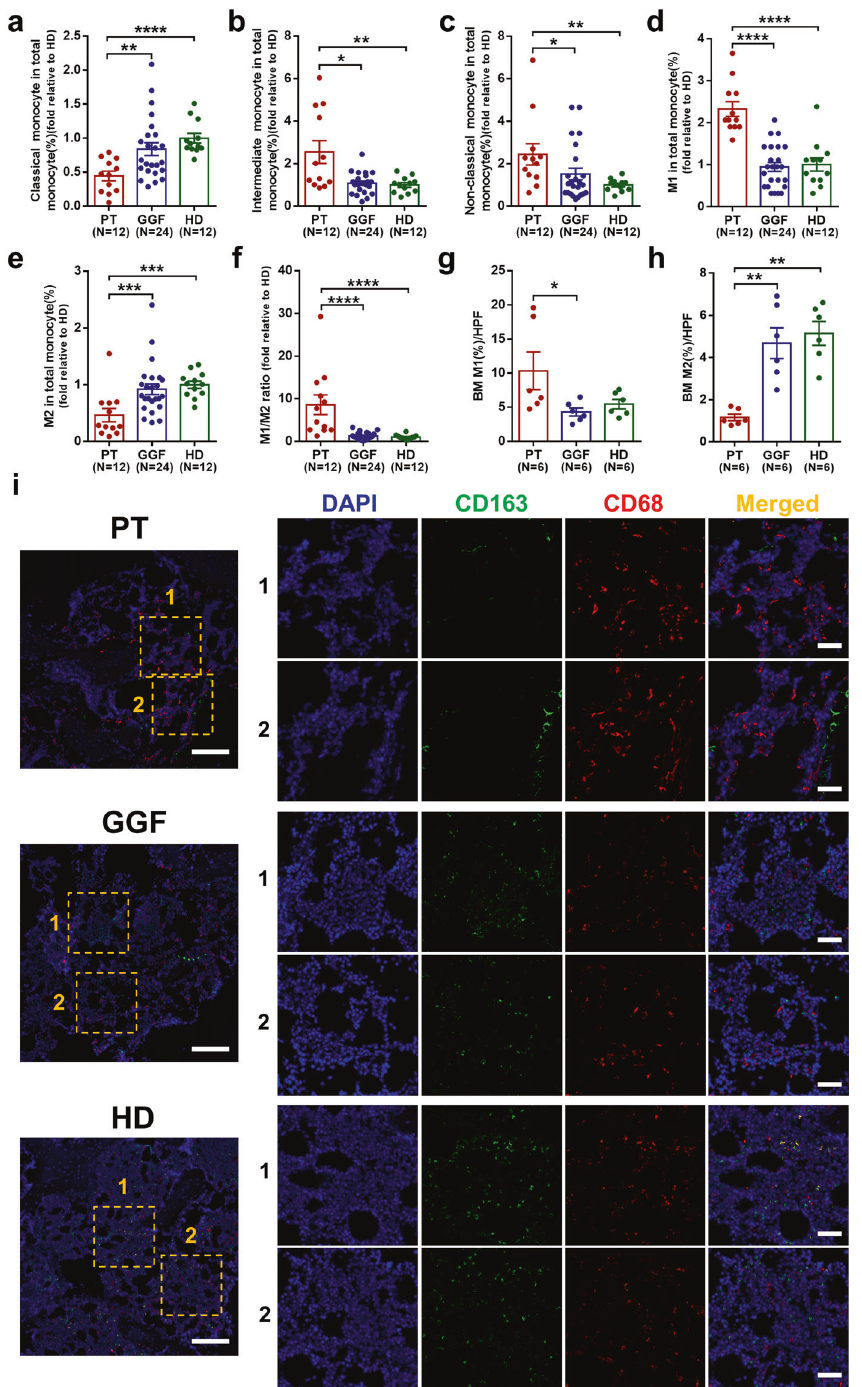
Fig. 1 Altered distribution of monocyte – macrophage subsets in the bone marrow of PT patients. Percentage of a classical monocytes, b intermediate monocytes, c non-classical monocytes, d M1 M Ф s, and e M2 M Ф s in the BM of PT patients, GGF patients and HDs as indicated by fl ow cytometry. f The M1/M2 ratio was calculated to represent the M Ф polarization status in PT patients, GGF patients, and HD. Positive area of g CD68 + M1 M Ф s and h CD163 + M2 M Ф s per high-power fi eld[HPF] in the BM trephine biopsies of PT patients, GGF patients, and HD as quanti fi ed by ImageJ. i M1 (CD68 + , red) and M2 (CD163 + , green) M Ф s in BM trephine biopsies from PT patients, GGF patients, and HD were visualized by immuno fl uorescence. Nuclei were counterstained with DAPI (blue). An overlay of the three colors reveals the number of M1 and M2 M Ф s in the BM trephine biopsies from the three groups (scale bars represent 50 μ m). The images (right panel) are enlarged from the labeled square areas of the left images. Data are presented as the means ± SEM (* P ≤ 0.05, ** P ≤ 0.01, *** P ≤ 0.001, **** P ≤ 0.0001)